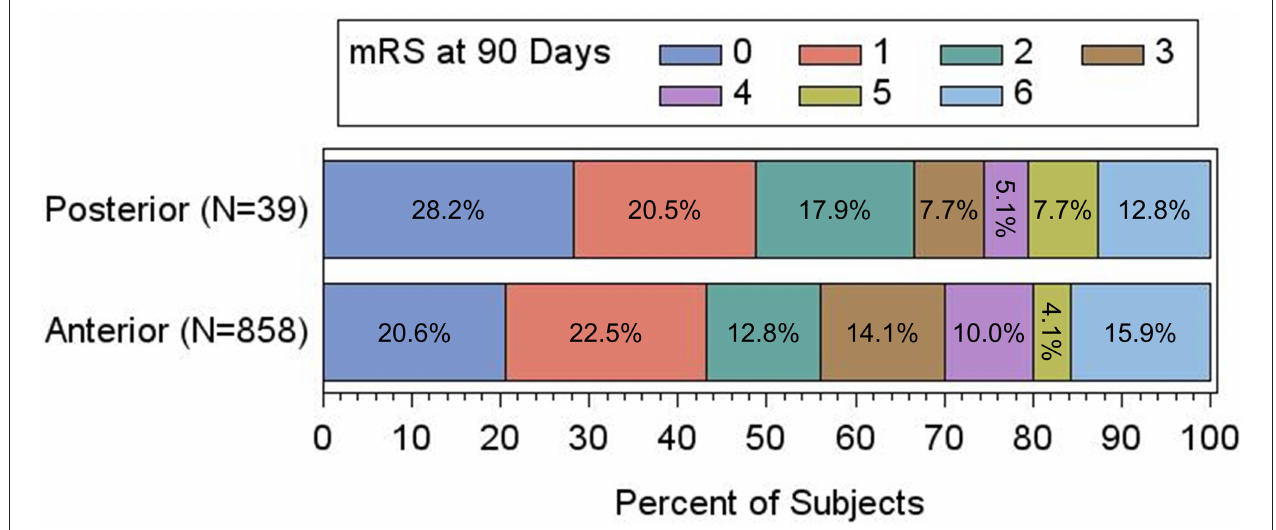
FIGURE 1 | Adjusted clinical outcomes at 90 days based on mRS, presented as percentage of the total in anterior vs. posterior circulation patients. There is no significant difference between the two groups by shift analysis ( P = 0.366 by Cochran-Mantel-Haenszel test).